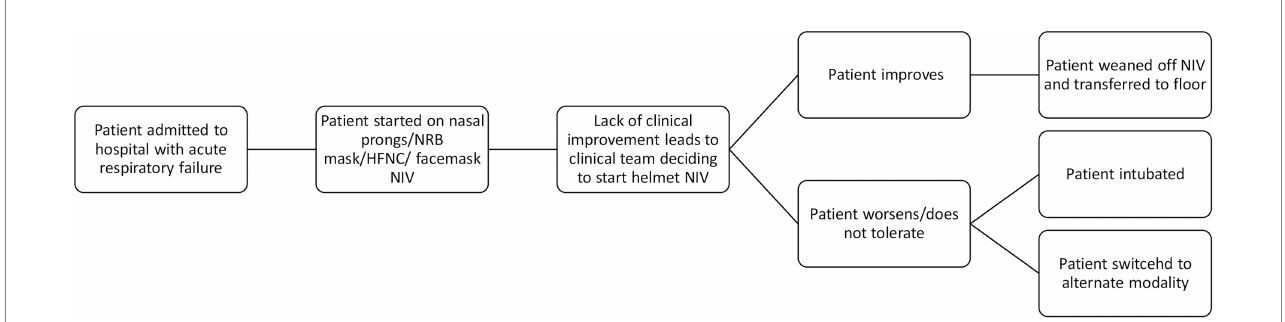
FIGURE 1 Clinical trajectory of a patient receiving helmet NIV. HFNC, high flow nasal cannula; NIV, non-invasive ventilation; NRB,